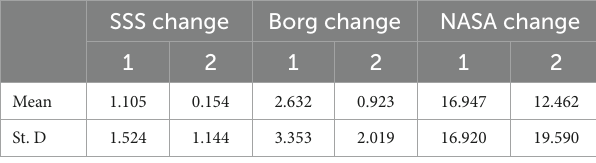
TABLE 4 Descriptive statistics change in fatigue and mental load with hours of usual